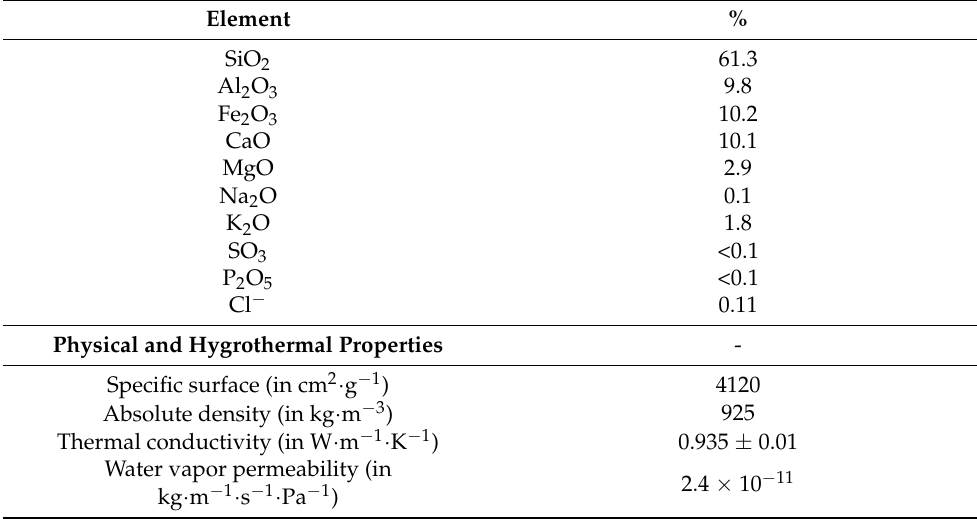
Table 5. Physical and chemical properties of GWM.